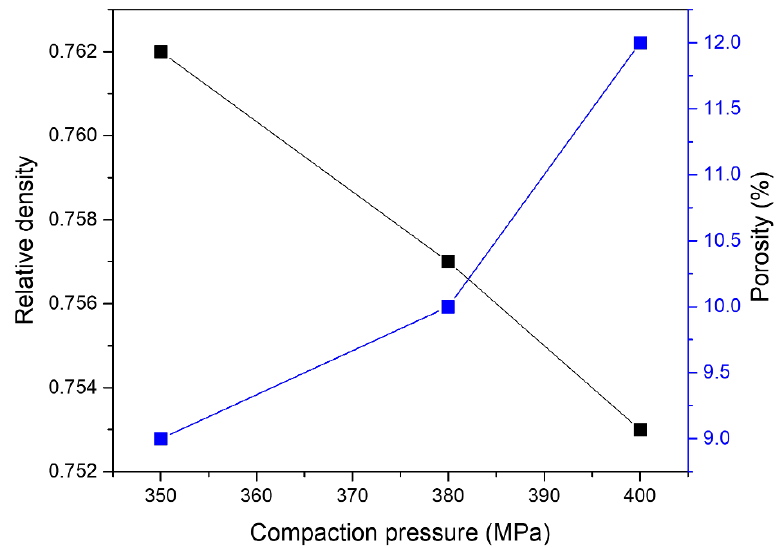
Figure 6. Effect of compaction pressure on relative density and porosity of Al compacts.